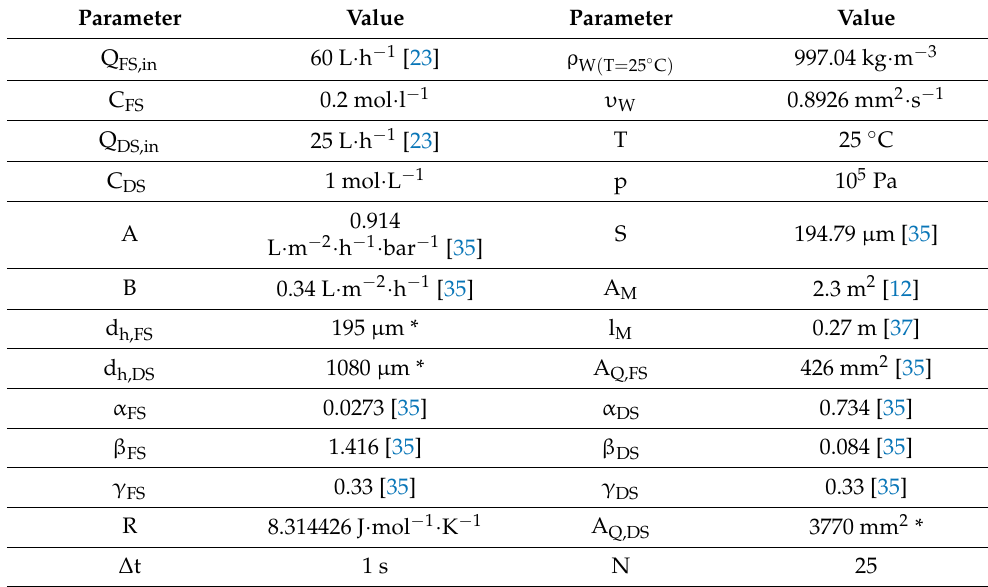
Table 1. Initial simulation parameter.